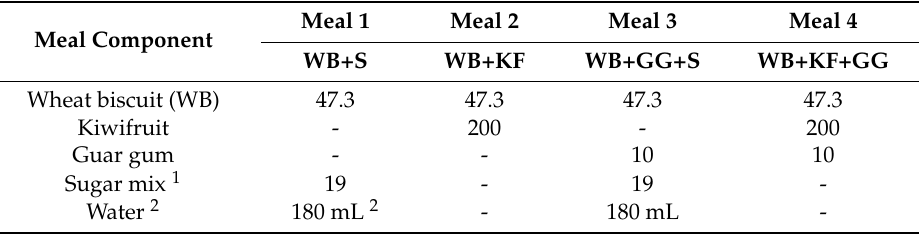
Table 1. Weights of meal components used (g).